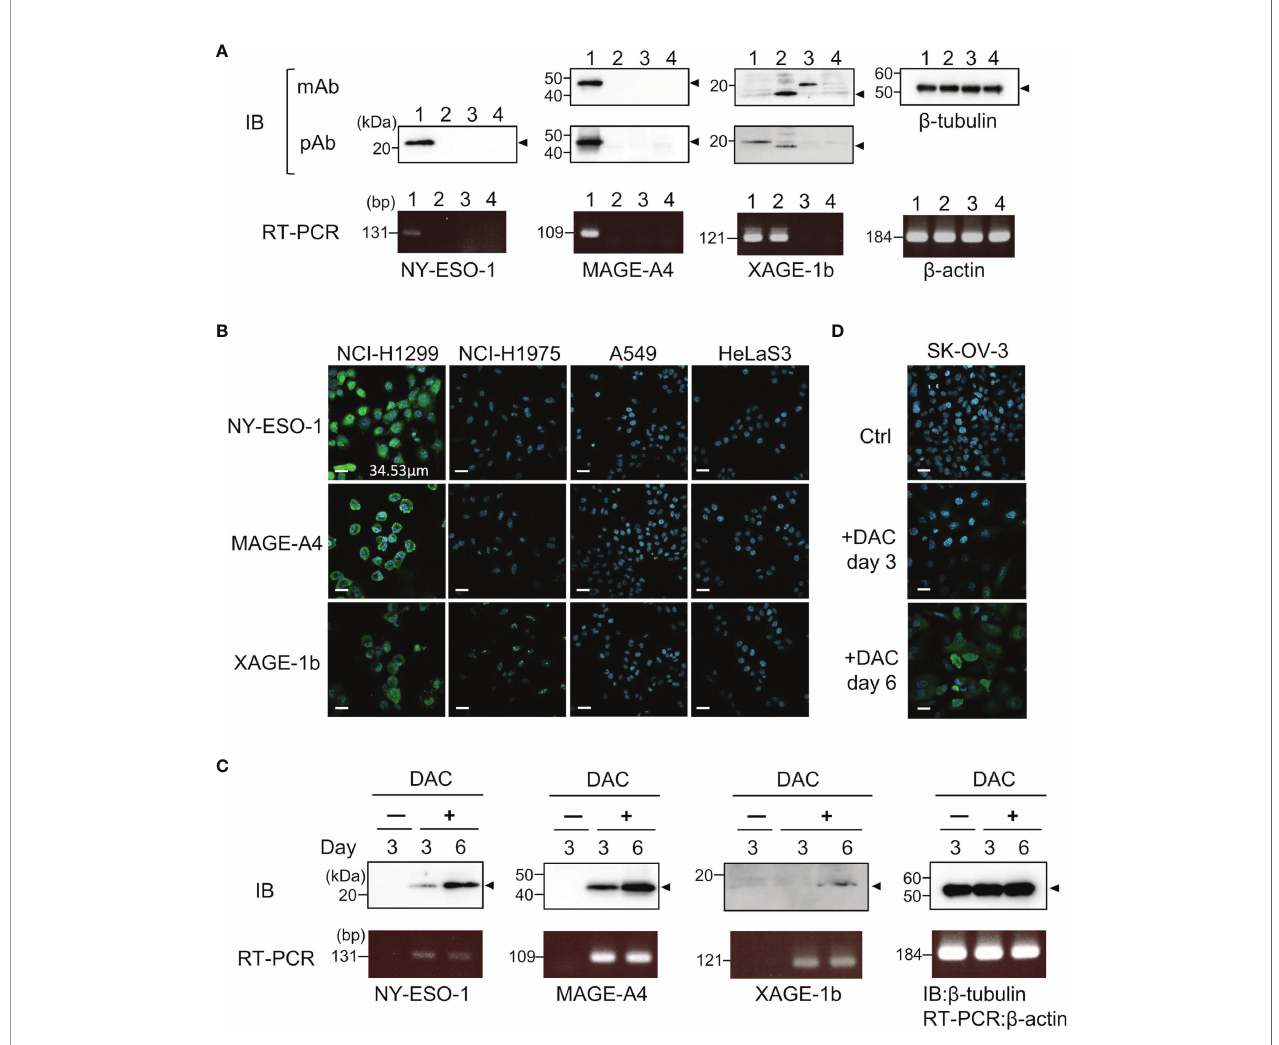
FIGURE 4 | Speci fi c binding of control IgGs developed by TAPS-antigen immunization was con fi rmed by the binding study of endogenous antigens. (A) Detection of intracellular antigens in cell lysates lane 1, NCI-H1299; lane 2, NCI-H1975; lane 3, A549; lane 4, HeLa S3 cells. Cell lysates were analyzed by western blotting with monoclonal antibodies or polyclonal antibodies (upper). mRNA expression levels of each antigen were evaluated by RT-PCR (lower). (B) Immuno fl uorescence staining of NCI-H1299, NCI-H1975, A549, and HeLa S3 cells for nucleus (blue) and intracellular antigens (green). (C) Detection of induced CTAs expression protein in SK-OV-3 cells treated with 5 m M DAC. Samples were collected after three or six days of cultivation with DAC. The upper panel is western blotting, the lower panel is RT-PCR. (D) Immuno fl uorescence staining of SK-OV-3 cells treated with 5 m M DAC for nucleus (blue) and intracellular NY-ESO-1